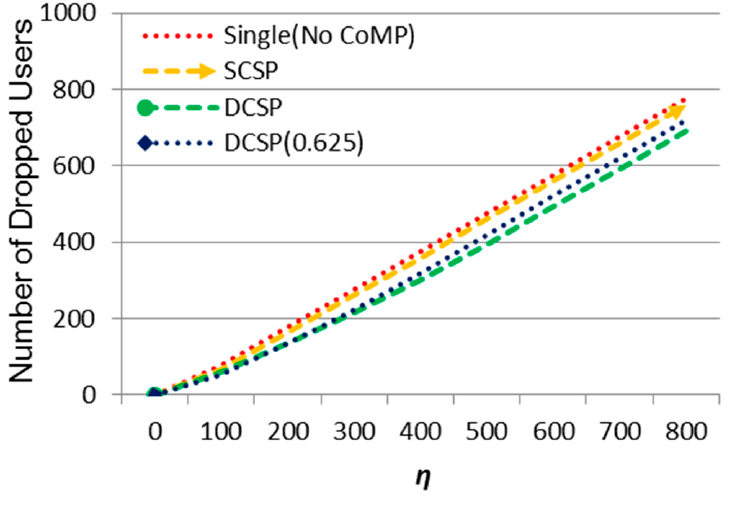
Figure 7. The effect of η on the number of dropped users.